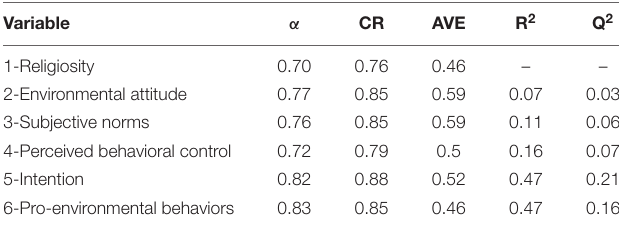
TABLE 3 | Cronbach’s alpha, CR, average variance extracted (AVE), R 2 , Q 2 values. Variable